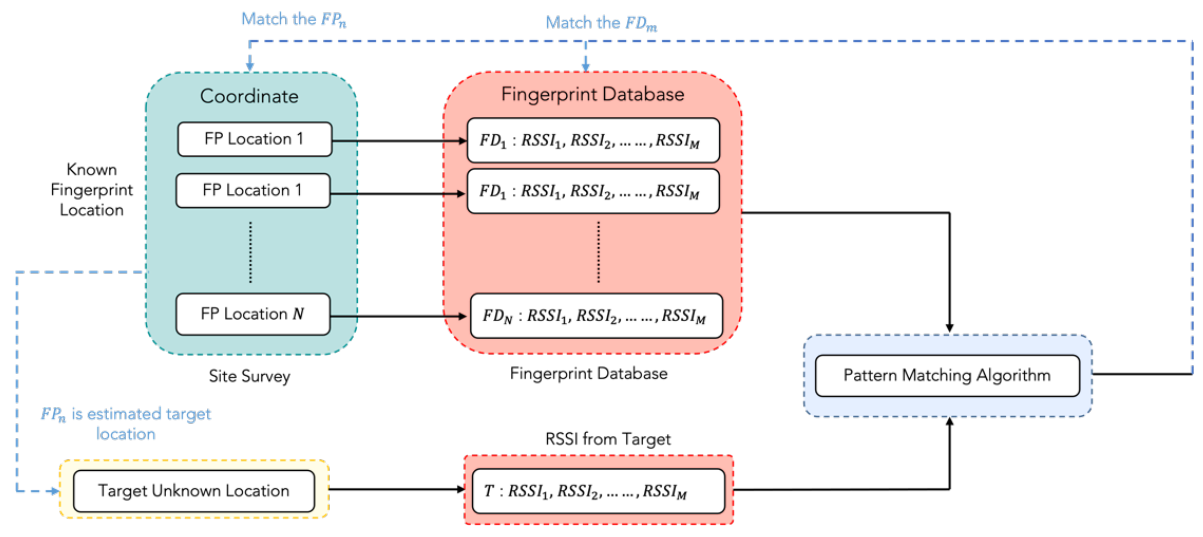
Figure 4. RSSI-based fingerprint technique.